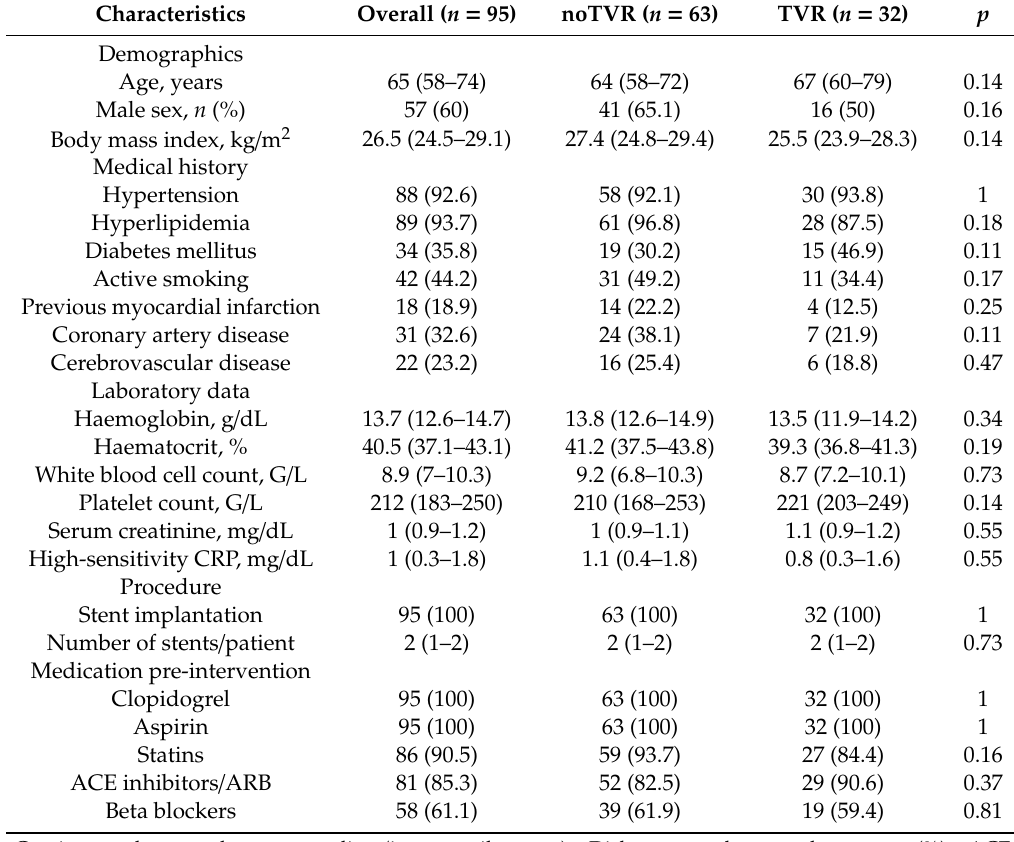
Table 1. Clinical, laboratory and procedural characteristics of the overall study population, and of patients. without and with target vessel restenosis